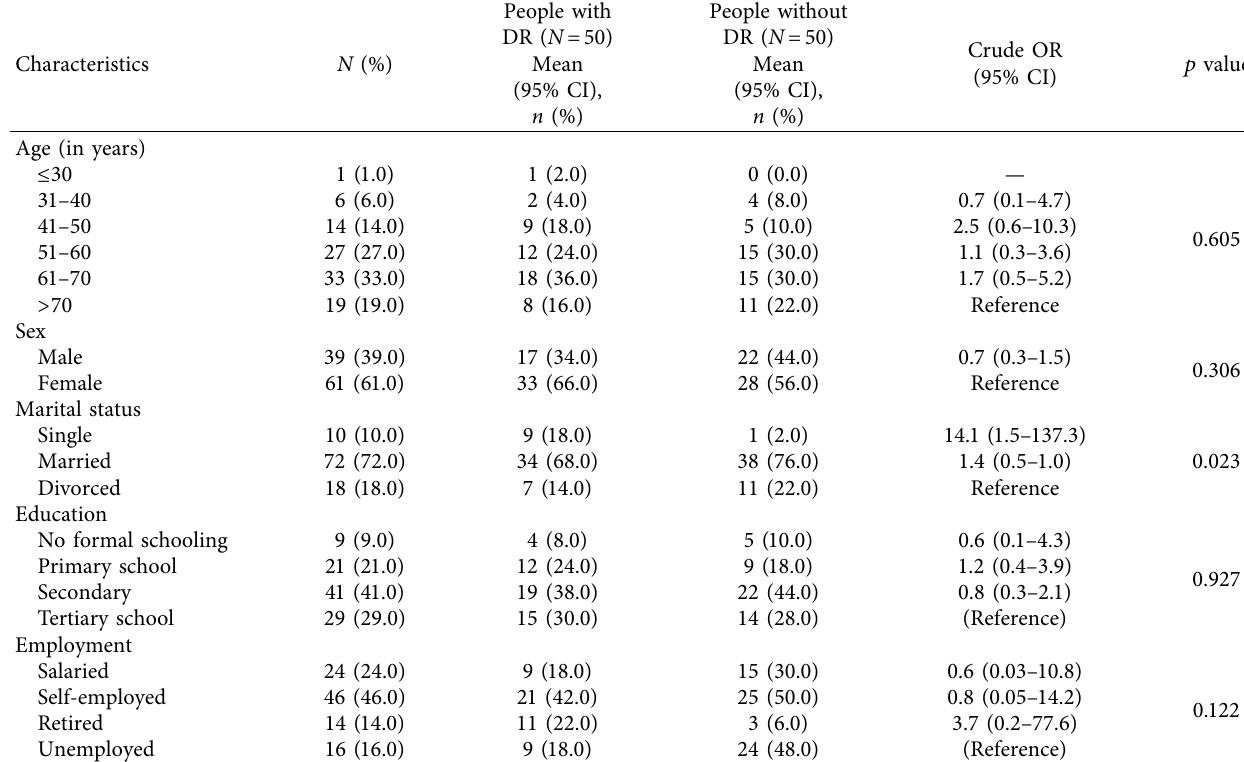
Table 1: Participants’ sociodemographic characteristics in relation to diabetes status at diabetes and eye clinics ( N � 100).